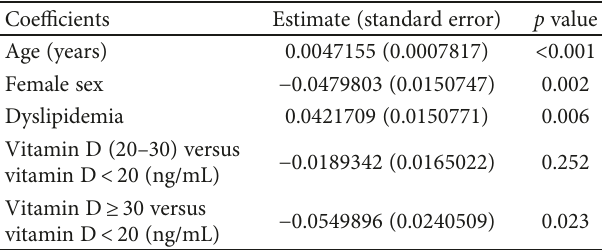
Table 3: Multivariable analysis for common carotid intima-media thickness.